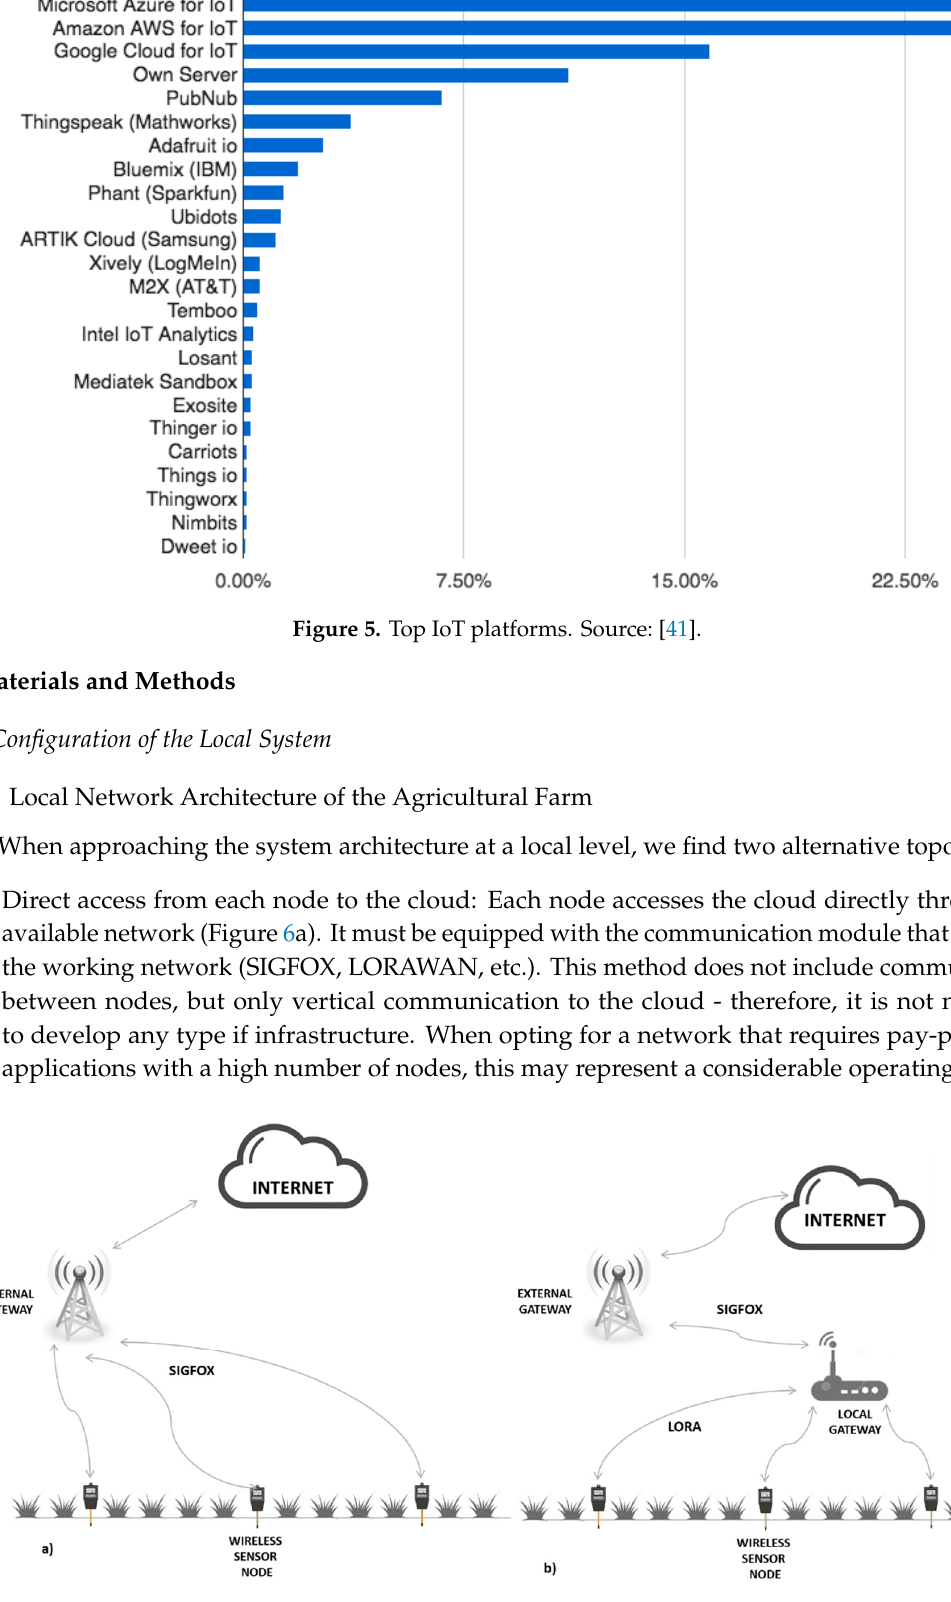
Figure 6. Local architecture configurations. Source: Own elaboration.